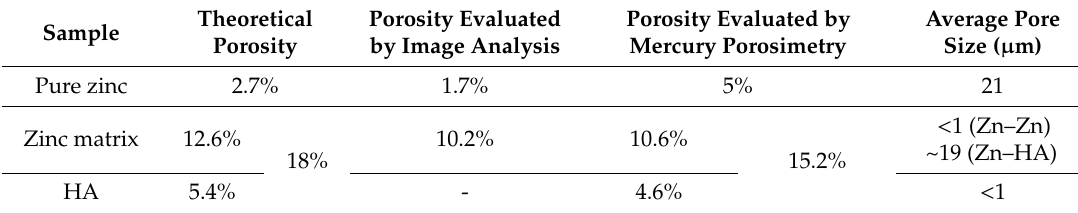
Table 2. Average pore size and porosity of pure zinc and zinc composite evaluated by di ff erent methods. Theoretical Porosity Evaluated Porosity Evaluated by Average Pore Sample Porosity by Image Analysis Mercury Porosimetry Size ( µ m) Pure zinc 2.7% 1.7% 5% 21 < 1 (Zn–Zn) Zinc matrix 12.6% 10.2% 10.6% ~19 (Zn–HA) 18% 15.2% HA 5.4% - 4.6% < 1